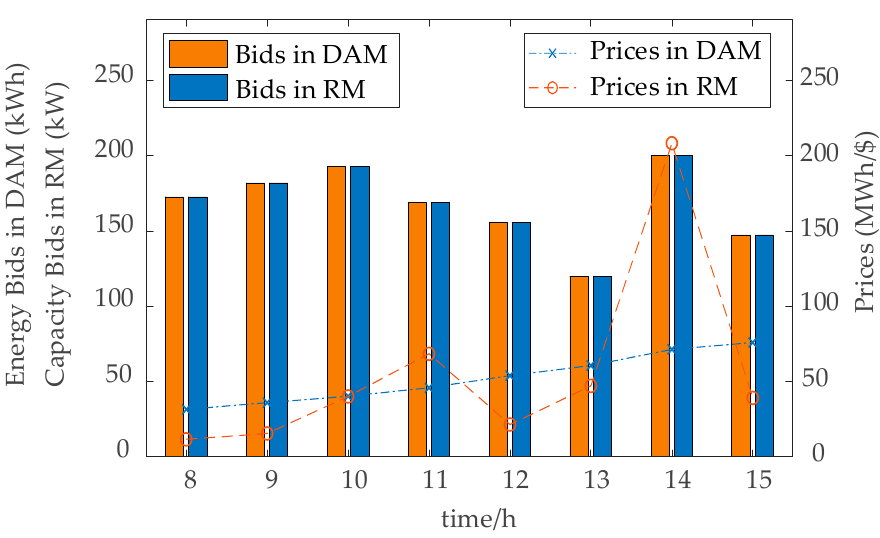
Figure 5. Market prices and the bid of the flow shop in day-ahead market (DAM) and regulation market (RM).